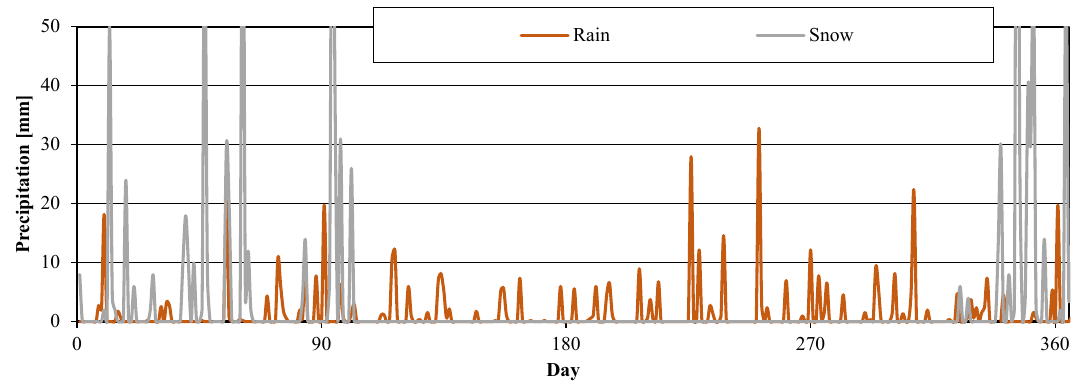
Figure 5. Total rainfall and snowfall in Toronto city.